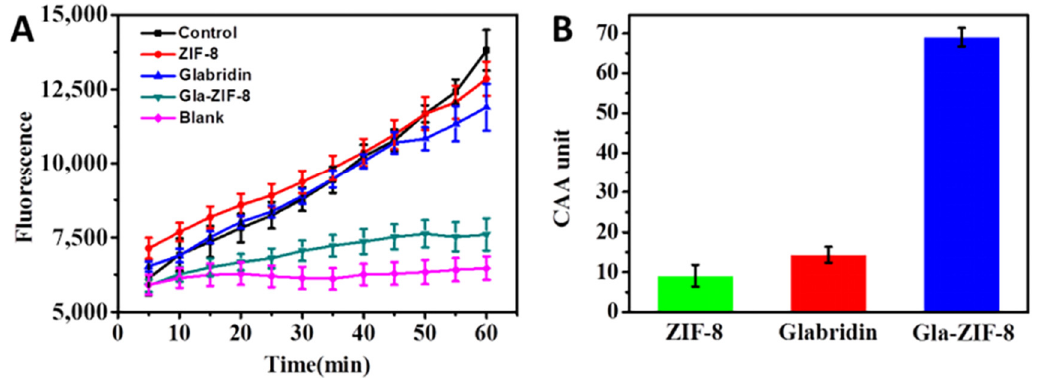
Figure 6. Kinetics curve of DCF fluorescence ( A ) and CAA values ( B ) of free glabridin, ZIF-8, and Gla-ZIF-8.